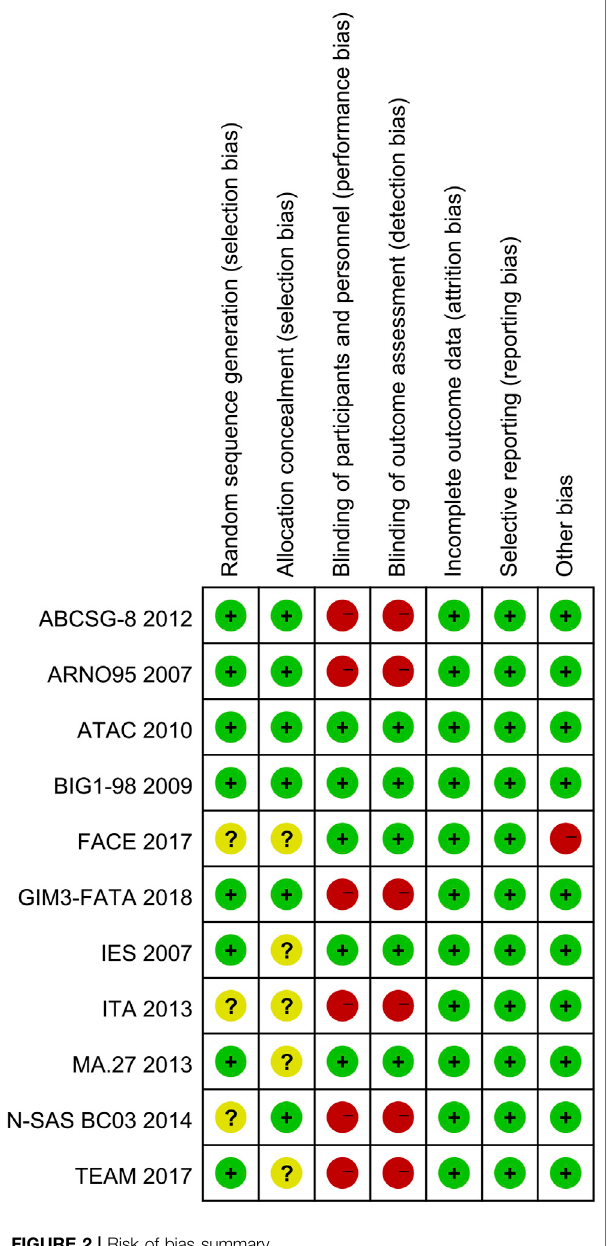
FIGURE 2 | Risk of bias